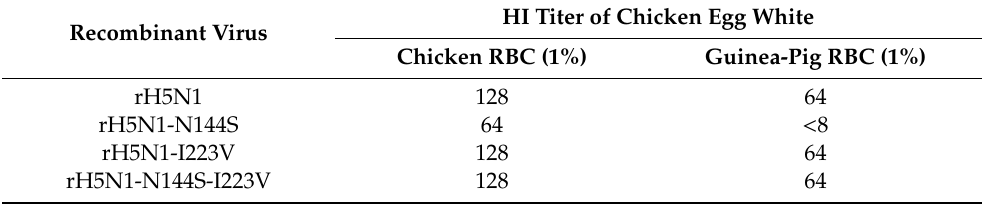
Table 6. Comparison of hemagglutination inhibition (HI) titers of egg white against the H5N1 recombinant viruses.